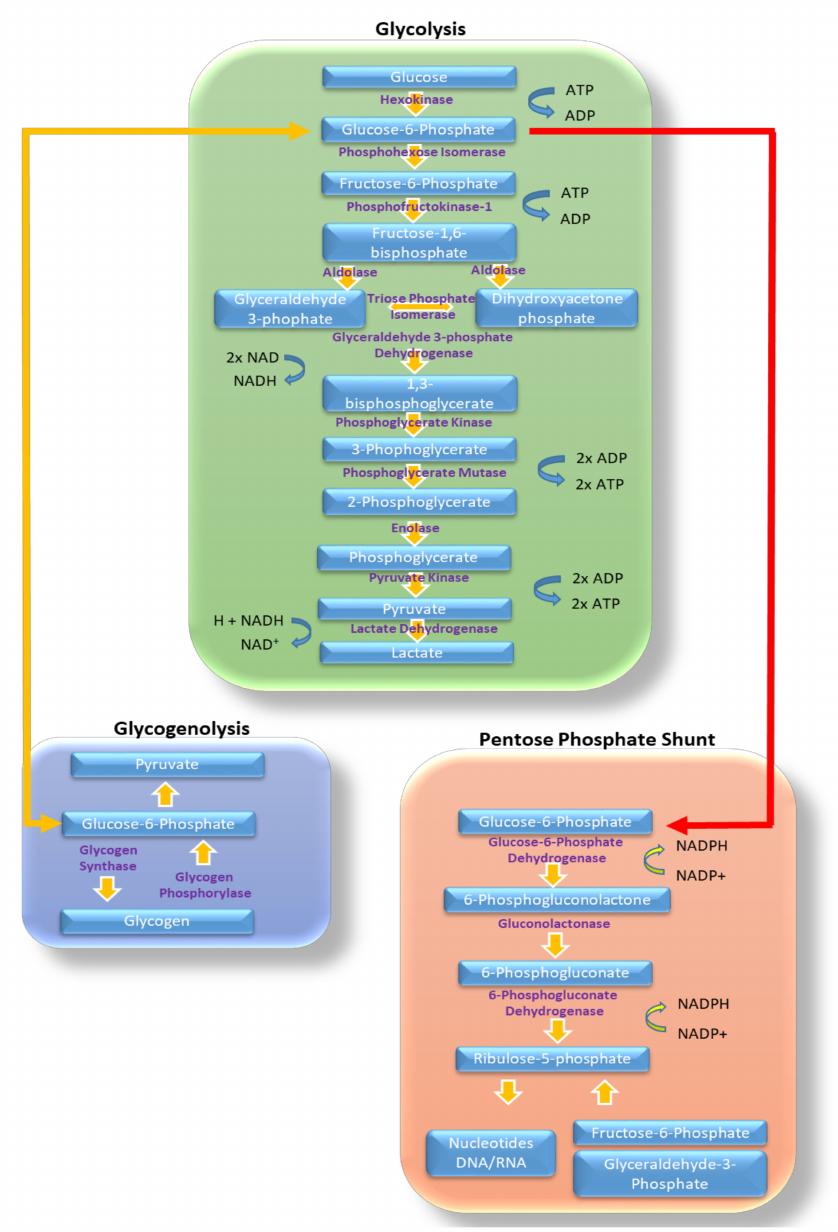
Figure 1. Glycolysis and other glucose metabolic pathways. Highlighted in this figure are the different enzymes and substrates involved in the metabolism of glucose via, glycolysis (green box), glycogenolysis (blue box) and in the pentose phosphate shunt (orange box). Sites of ATP, NADPH, NADH, and ADP generation are shown. Sites of transfer of glucose products between metabolic pathways are highlighted with yellow arrows for movement into glycogenolysis and red for movement though the pentose phosphate